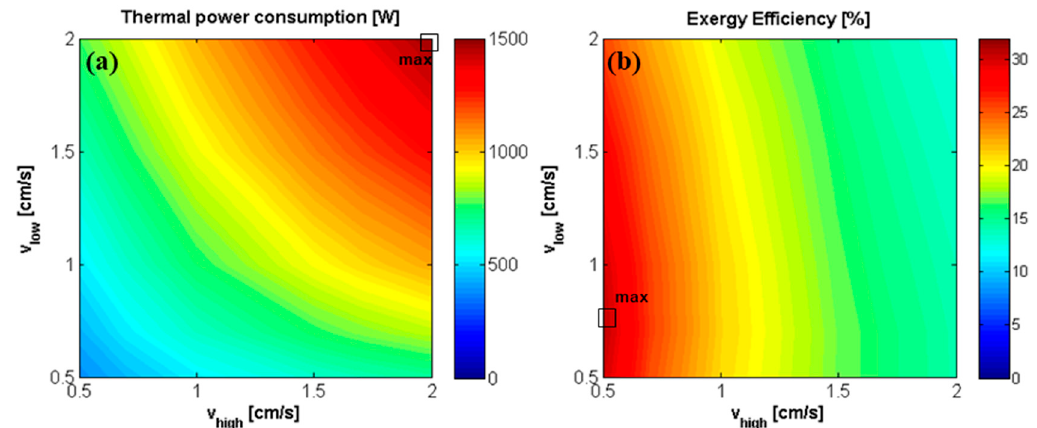
Figure 16. Effect of inlet solutions velocity on ( a ) thermal power consumption [W] of the MED unit, and on ( b ) exergy efficiency of the RED-MED system. RED stack: 50 cell pairs, ideal membranes, membrane area of 0.1 × 0.88 m 2 , counter-current arrangement, C H , in = 4.5 M and C L , in = 0.05 M. MED: T hot = 100 ◦ C, T cold = 20 ◦ C, optimized number and area of the effects. The results obtained can be compared with other RED-HE works published in the